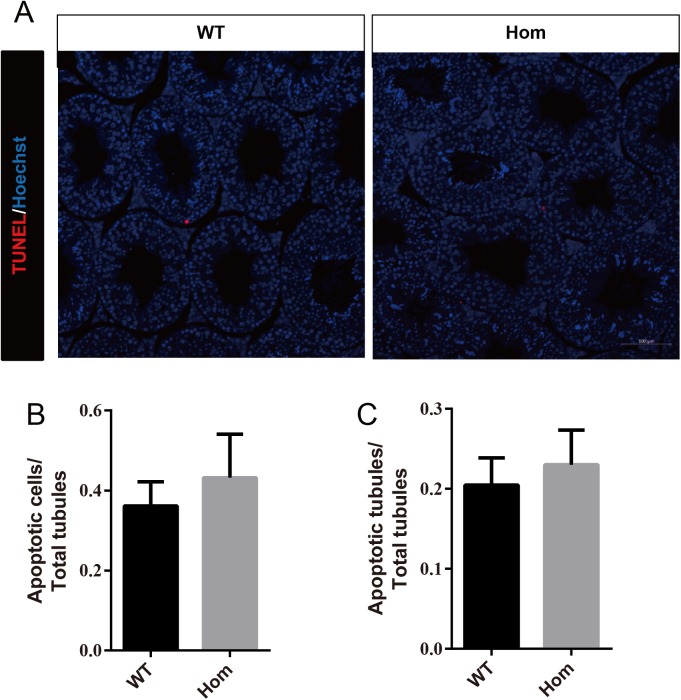
Apoptotic cells are not increased in Fank1−/− testes.(A) TUNEL assay of wild-type and Fank1−/− testes; (B) average apoptotic cells per seminiferous tubule; (C) average apoptotic cells per seminiferous tubules, n = 3, P > 0.05.